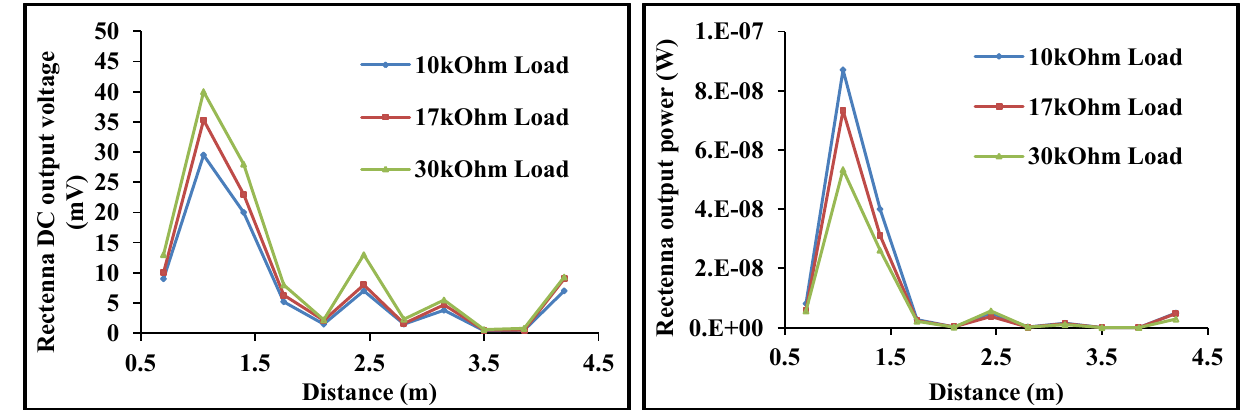
Figure 19. Rectenna receiving range performance by sending 17 dBm (50 mW) at a gain of −6 dBi at 437 MHz. Output DC voltage versus receiving distance for different loads ( left ), loads output power versus receiving distance ( right